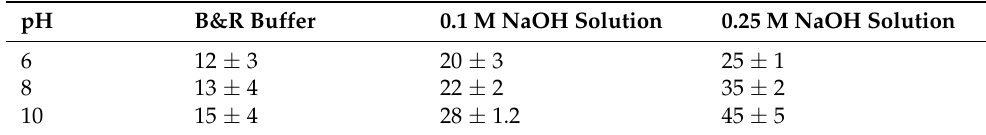
Table 2. APL solubilization at different pH (6, 8, and 10) in B&R buffer and NaOH solution conditions